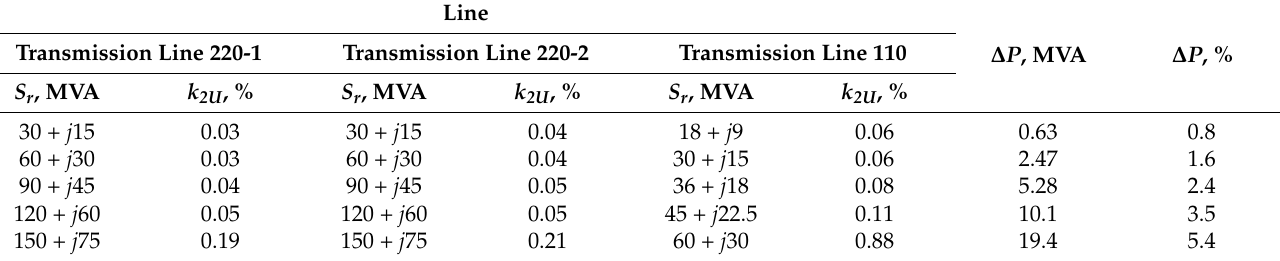
Table 2. Load capacities, losses, and unbalance of a three-circuit transmission line.